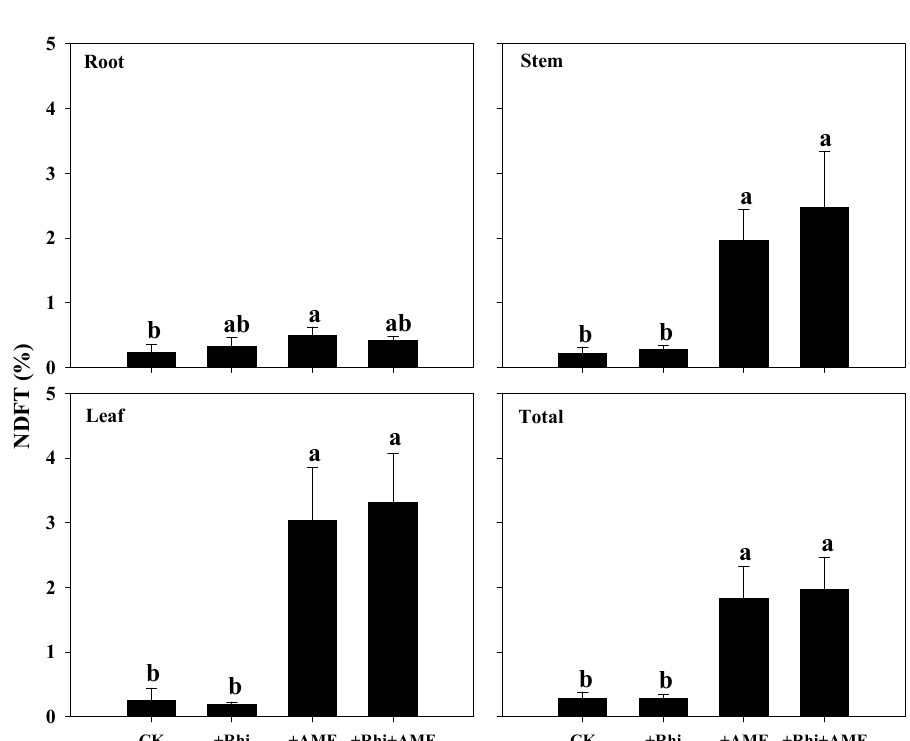
Figure 5. Percentage of N derived from transfer (NDFT) in various parts of citrus affected by rhizobial and mycorrhizal inoculation. Data are means ± SE ( n = 4). Different letters above columns indicate significant differences ( p < 0.05) between treatments. Abbreviations: CK, no rhizobial and no arbuscular mycorrhizal inoculation; +Rhi, inoculated with rhizobium; +AMF, inoculated with mycorrhizal fungus.